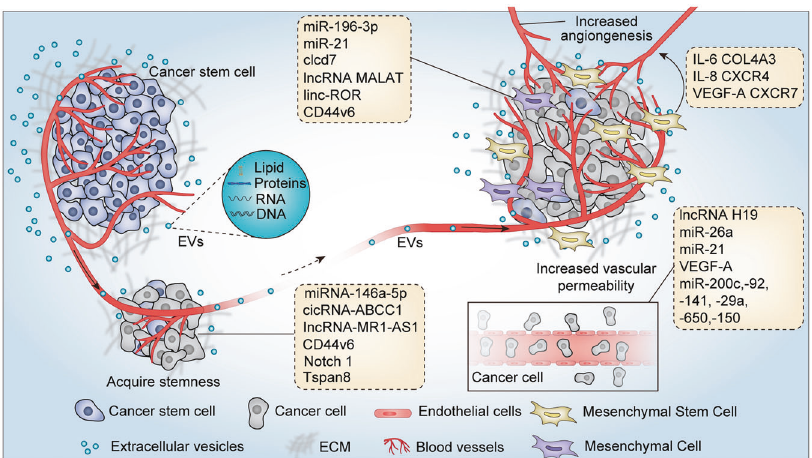
Fig. 3 Cancer stem cells-derived EVs promote tumor metastasis, angiogenesis, and cancer stem-like phenotype. CSCs-derived EVs confer non- CSCs stem-like characterizes through delivering miRNA, lncRNA, cicRNA, and stemness-related proteins or activating stem-related signaling pathways. In addition, CSCs-derived EVs carry multiple bioactive molecules to promote tumor cells EMT, tumor angiogenesis, and vascular permeability, which make a signi fi cant contribution to cancer metastasis. CSCs-derived EVs also instigate mesenchymal stem cells to secrete a variety of signaling molecules, such as IL-6, IL-8, VEGF-A, COL4A3, CXCR4, and CXCR7, thereby promoting tumor